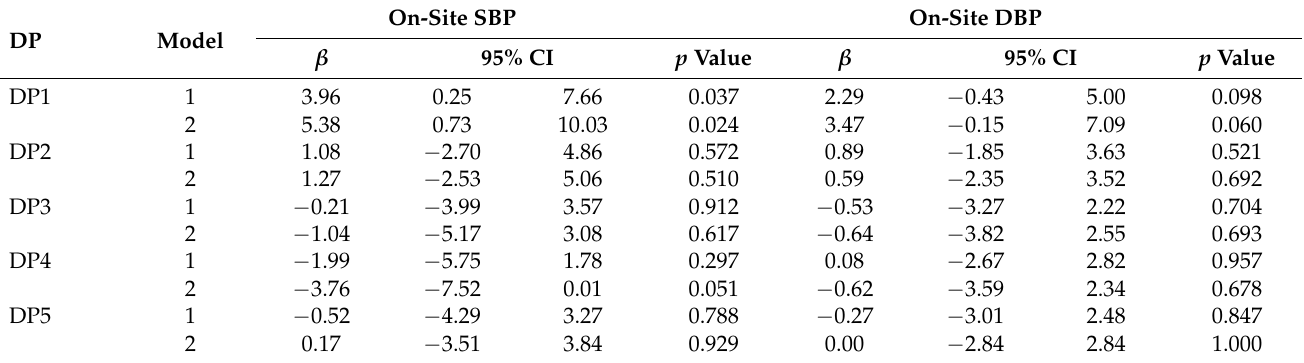
Table 5. Association between dietary pattern and on-site blood pressure in multiple linear regression